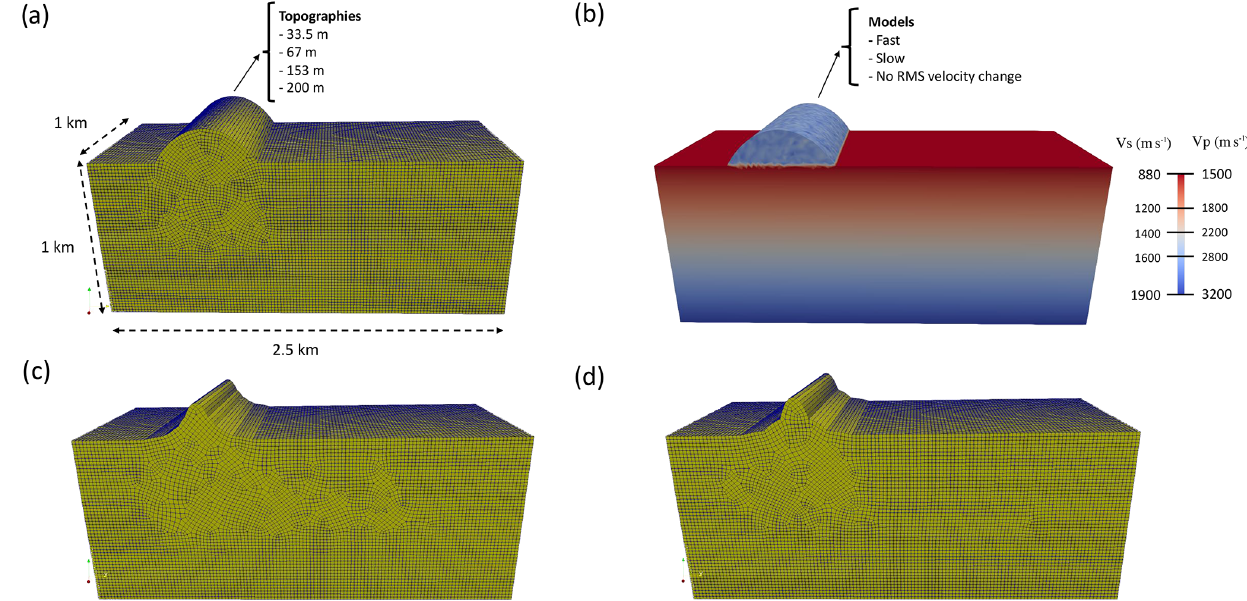
Figure 7. (a) Mesh examples of large-scale models with topographic mounds as shown. The length of the models is 2.5km, and topography heights are shown. (b) Velocity model outside the mound with increasing velocity with depth as shown by the colors. Inside the mound, velocity variations with and without scattering are included as shown. With scattering the rms velocity is either higher, lower or the same as the top layer of the box at zero elevation. Without scattering the velocity is either higher, lower or the same as the top layer of the box. (c, d) Two different models with more complex topography: (c) smoother model and (d) rougher model.